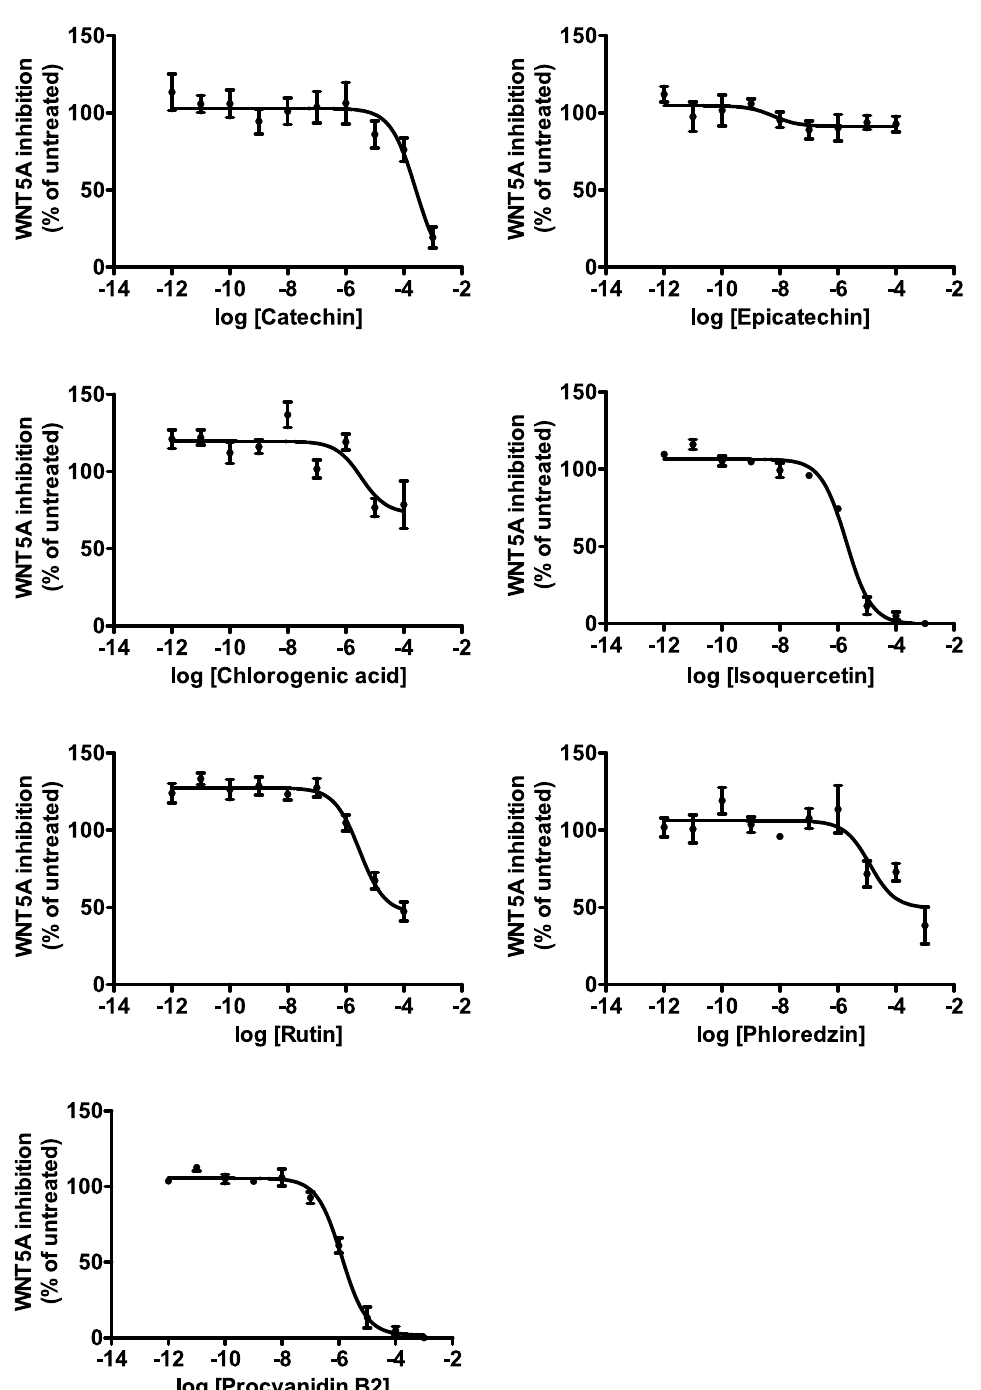
Figure 2. WNT inhibitory activity of apple polyphenols. Dose-response curves represent the indicated compounds modulation of WNT pathway in HEK293 cells. Values are reported as mean ± SD ( n = 3). EC 50 values for each compound are reported in Table